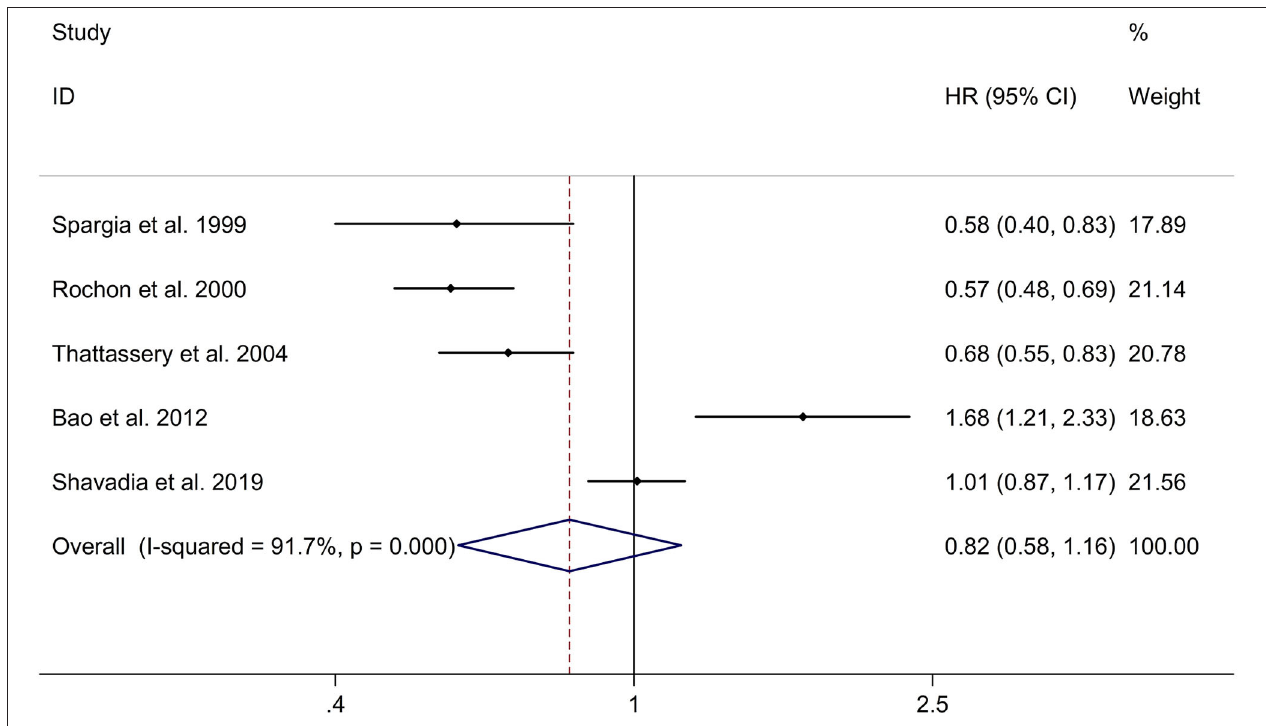
FIGURE 3 | Forest plots exploring the long-term effect of β -blocker use on risk of hospitalization for HF in patients after MI. CIs, confidence intervals; HF, heart failure; HRs, hazard ratios; MI, myocardial